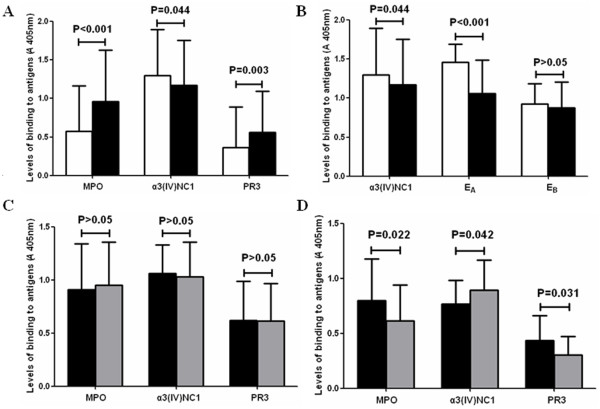
Comparison of antigen-binding levels between non-SNA-binding IgG and SNA-binding IgG. A: Comparison of binding levels to MPO, α3(IV)NC1 and PR3 between non-SNA-binding IgG and SNA-binding IgG. Open squares represented non-SNA-binding IgG; Filled squares represented SNA-binding IgG. B: Comparison of binding levels to α3(IV)NC1, EA and EB between non-SNA-binding IgG and SNA-binding IgG. Open squares represented non-SNA-binding IgG; Filled squares represented SNA-binding IgG. C: Influence of neuraminidase treatment on the antigen-binding levels of SNA-binding IgG. Filled squares: before treatment; gray squares: after treatment D: Influence of endoglycosidase F2 treatment on the antigen-binding levels of SNA-binding IgG. Filled squares: before treatment; gray squares: after treatment.